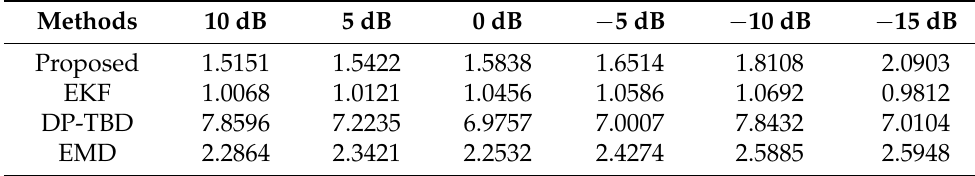
Table 4. Comparison of the time cost (s) among the proposed method, the EKF method, the traditional DP-TBD method, and the EMD method with different SNR